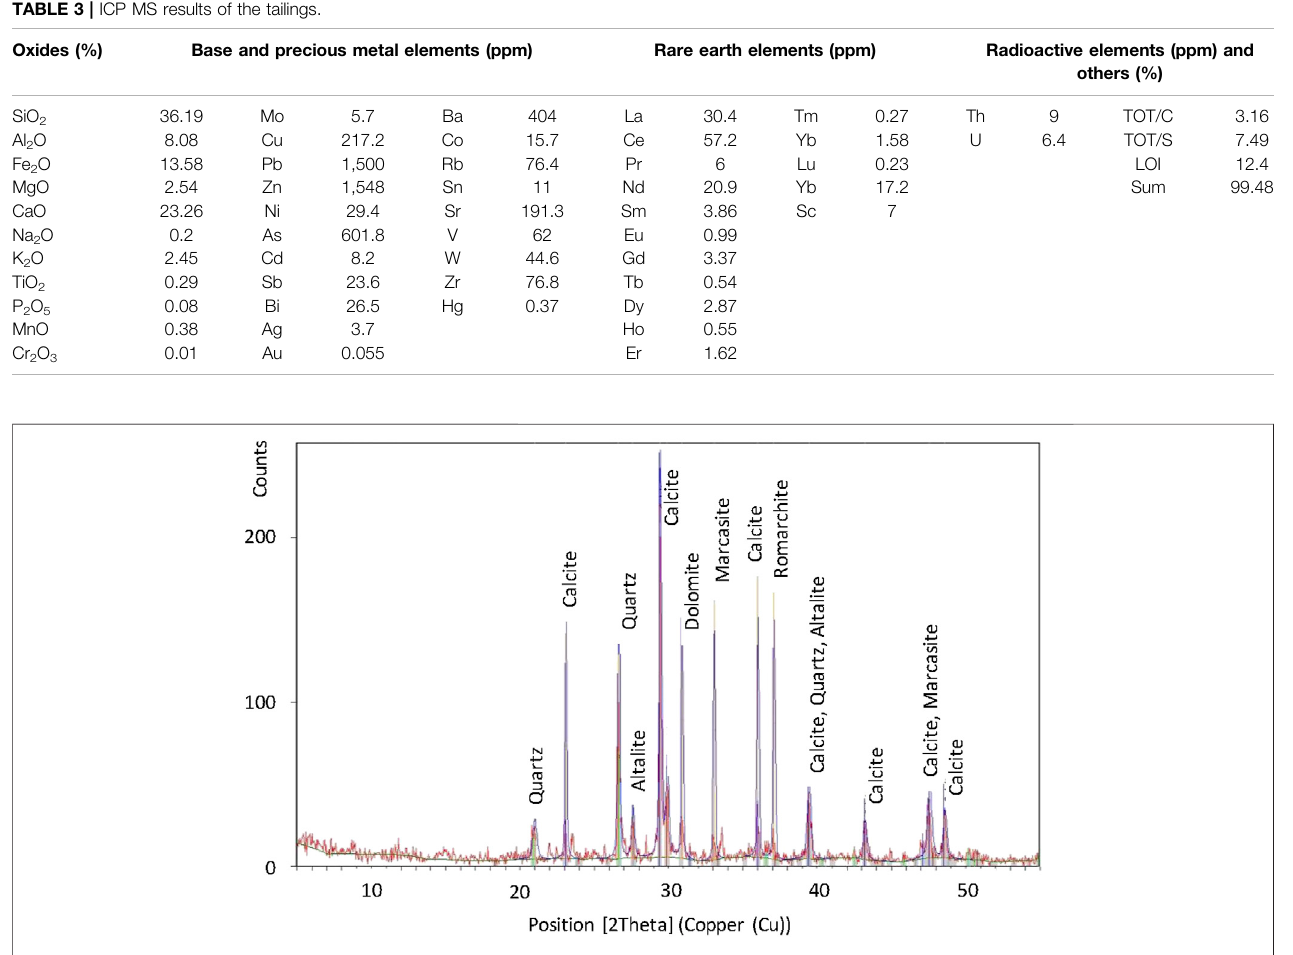
TABLE 3 | ICP MS results of the tailings.